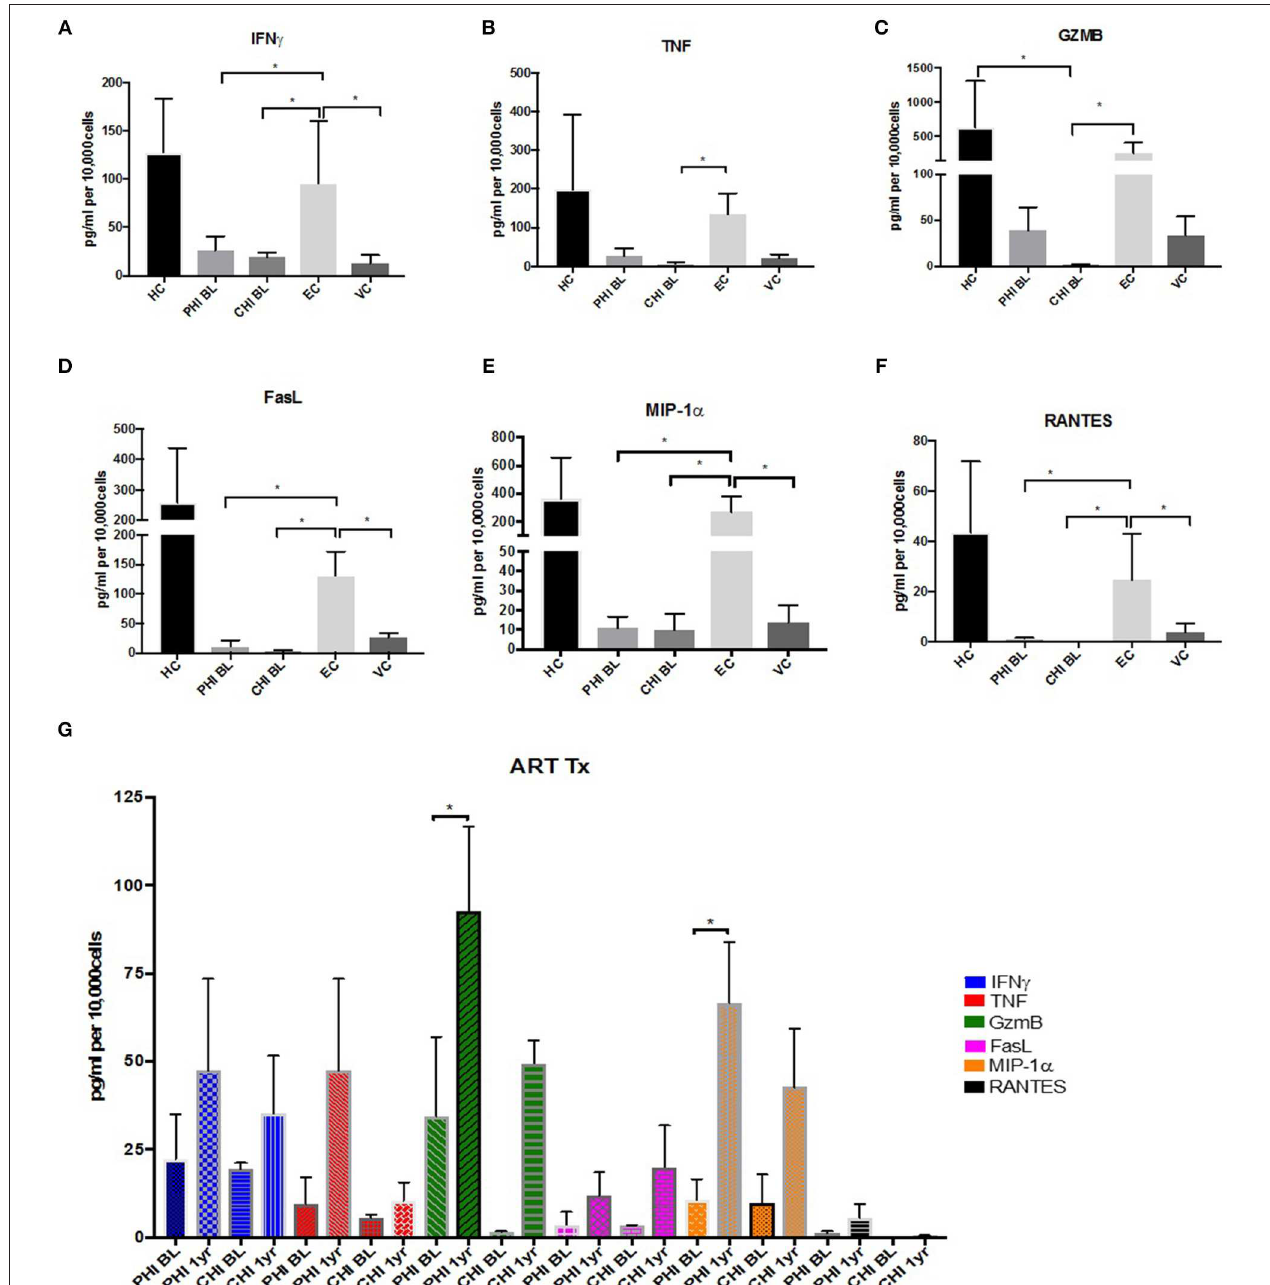
FIGURE 7 | Maintenance of effector cytokine and beta chemokine expression in EC. (A) IFN γ (B) TNF (C) GzmB (D) FasL (E) MIP1- α (F) RANTES expression levels in Healthy controls (HC), PHI and CHI baseline (BL), LTNPs EC and VC. (G) Increased expression levels after 1-year ART in PHI and CHI. * p < 0.05.